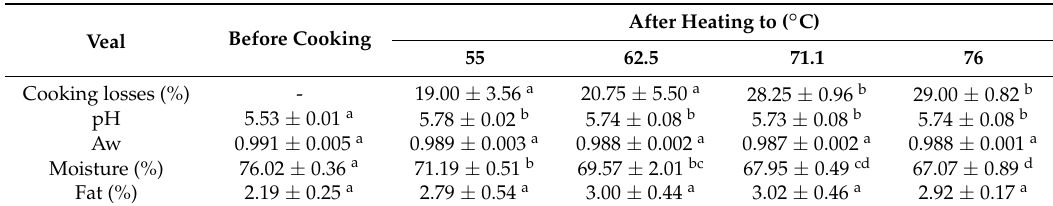
Table 2. Cooking losses, pH, water activity, and moisture and fat contents of non-intact course ground veal patties before and after cooking to various internal end-point